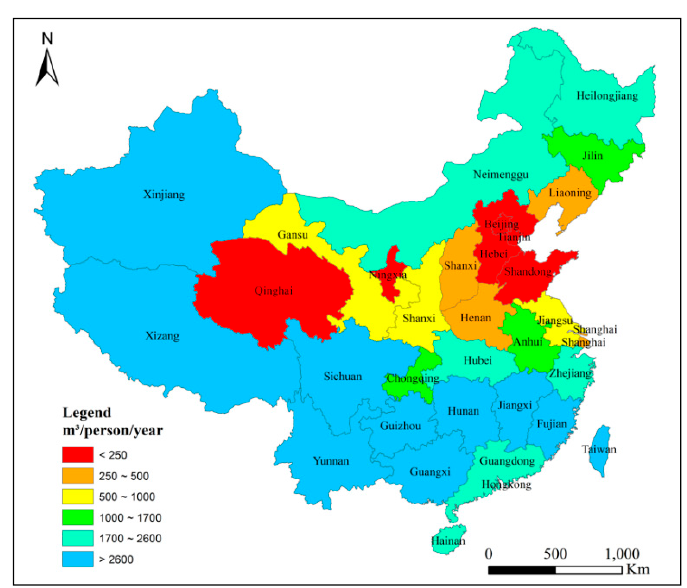
Figure 1. Per Capita Water Resources of Each Province in China in 2015. Table 4. Indicator Data for Beijing-Tianjin-Hebei in 2004–2015.